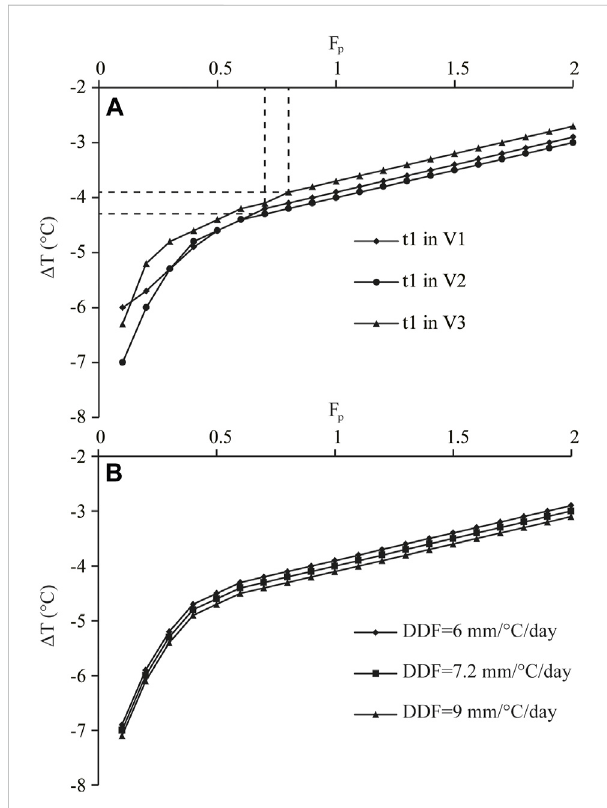
(Figure 4A). The modeled ELAs in V1, V2, and V3 under this climate condition were 4215, 4198, and 4247 m asl,